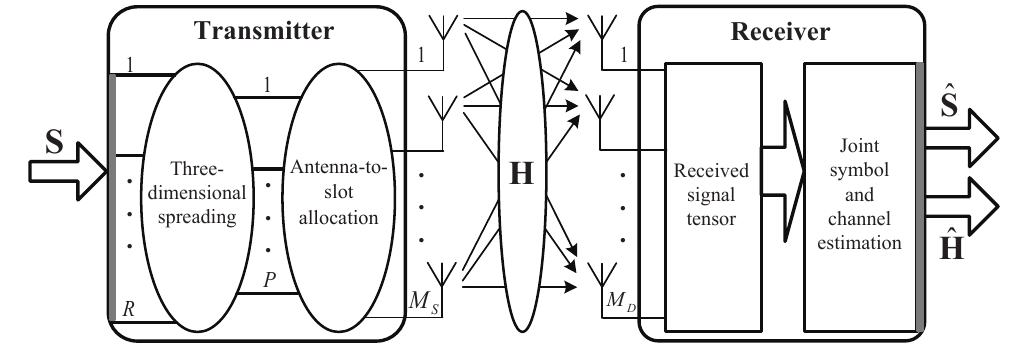
Figure 1. Block-diagram of the system